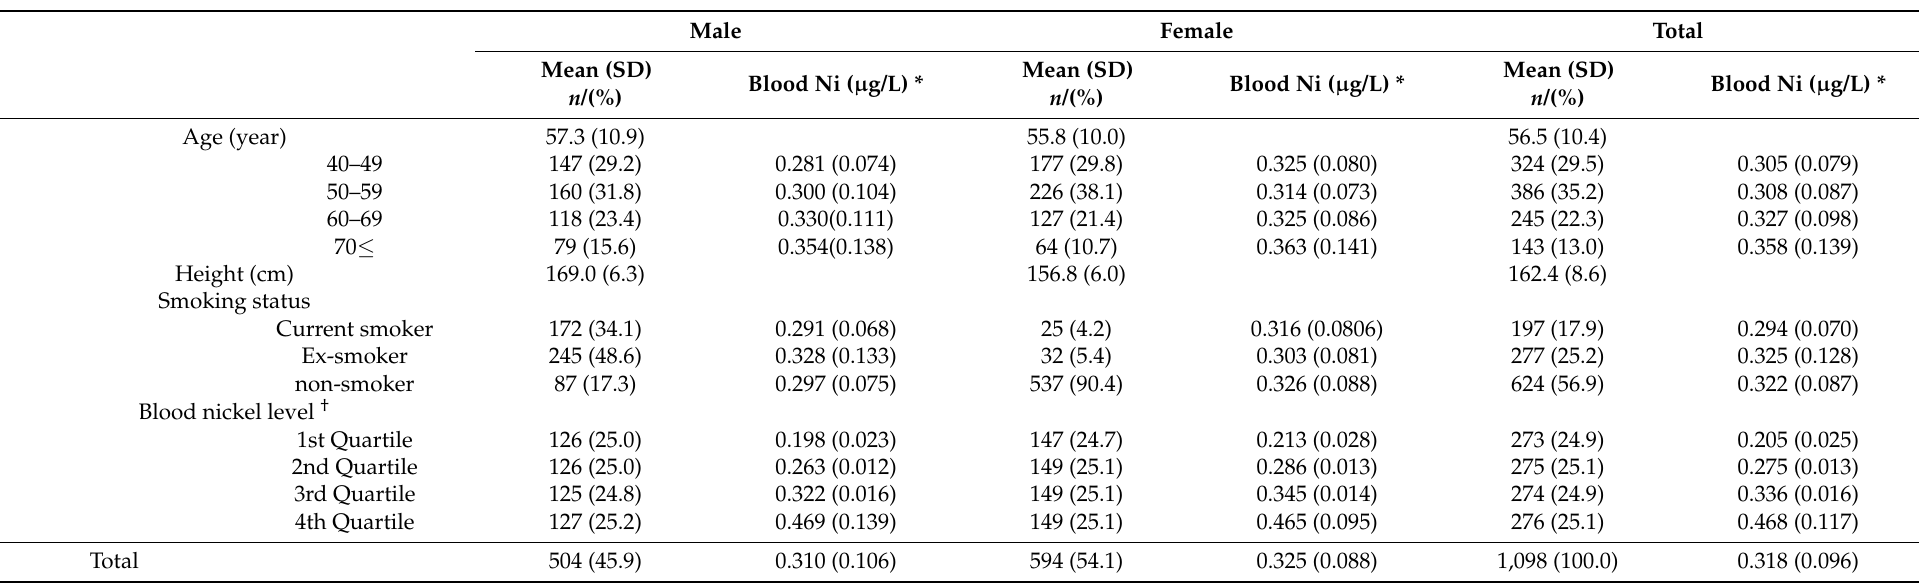
Table 1. General characteristics and blood nickel concentrations in a Korean general population by